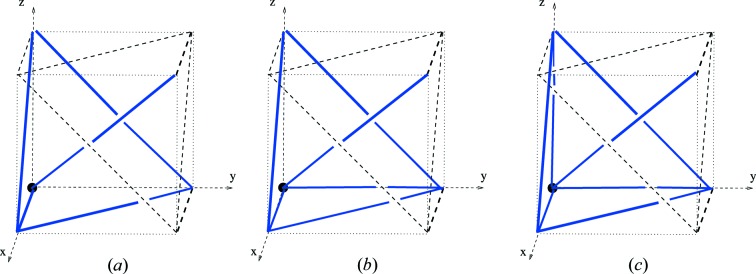
Motifs for the model nets (a)  (b)  and (c)  (14T957) which have a 32-penetrating edge.